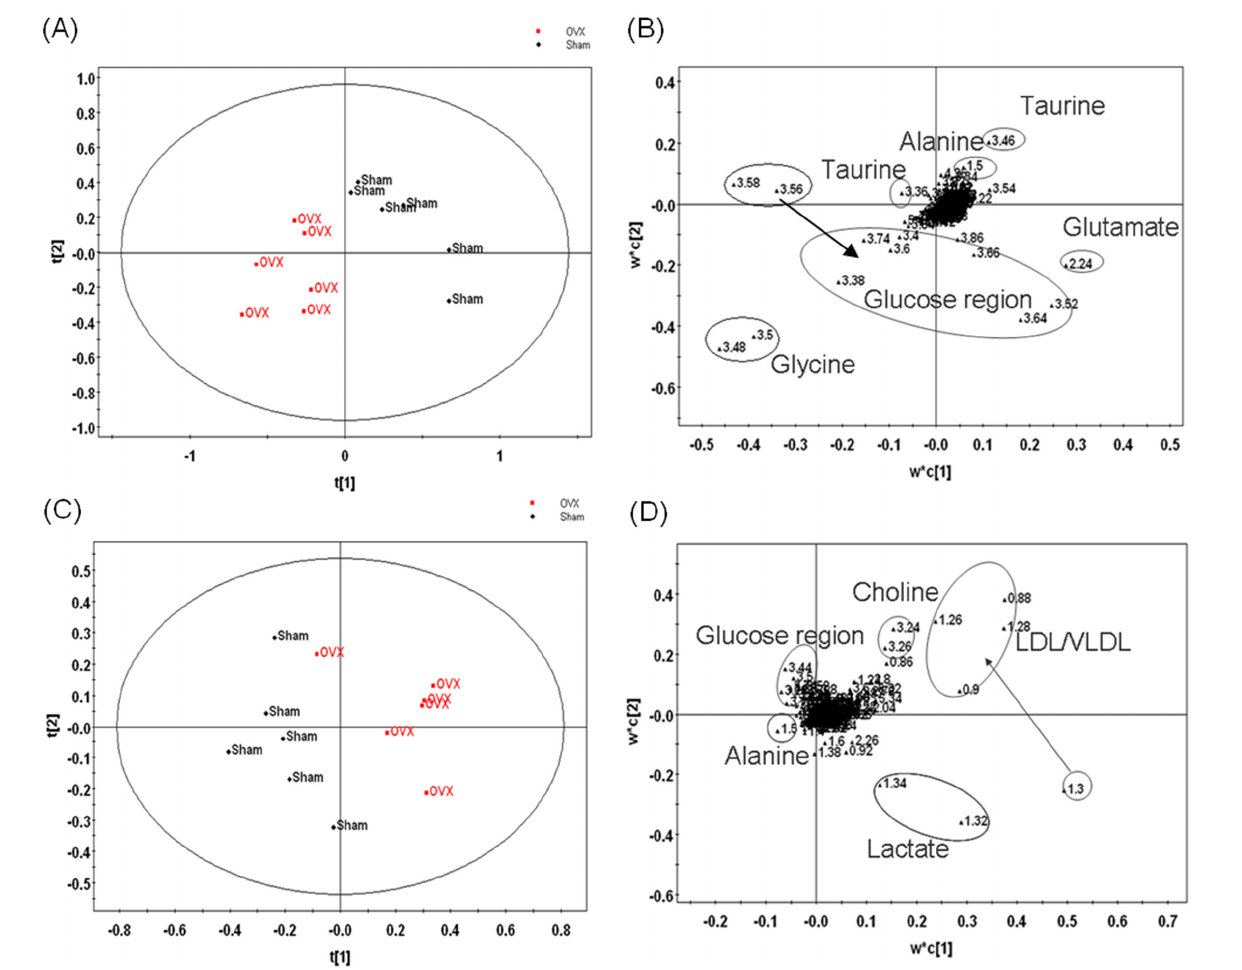
Figure 2. PLS-DA scores plot ( A ) and corresponding loadings plot ( C ) are based on the 1 H NMR spectra of the plasma samples from Sham (■) and OVX( ◆ ); Scores plot ( B ) and corresponding loadings plot ( D ) are based on the 1 HNMR spectra of the urine samples from Sham(■) and OVX( ◆